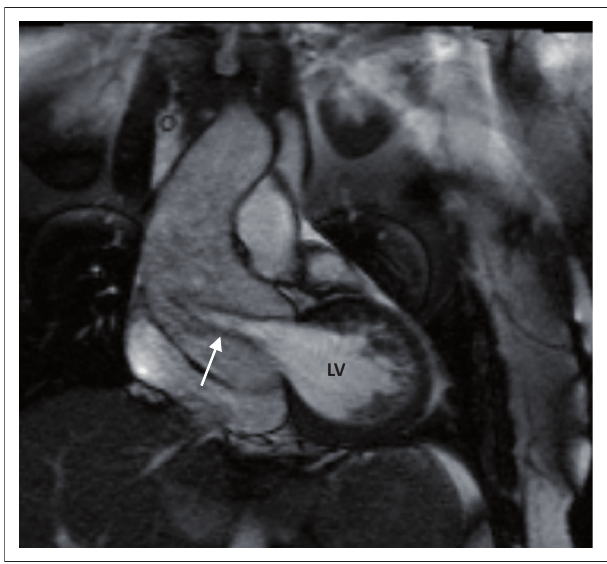
LV, left ventricle. FIGURE 14: Coronal cine SSFP image of the aortic valve demonstrates a jet (white arrow) distal to the valve as a result of aortic valve stenosis.